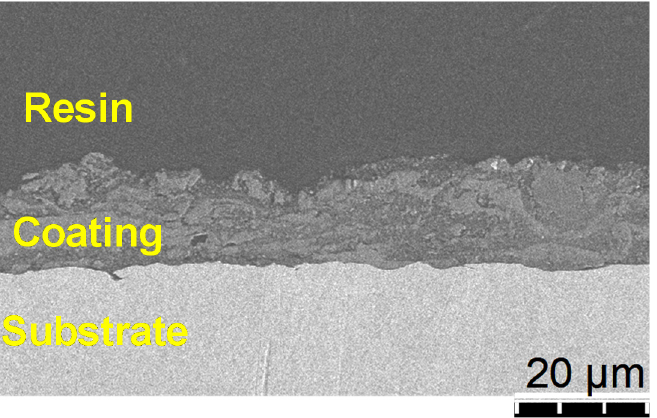
Figure 6. Cross sectional view of the AlN-rich coating on carbon steel by SEM imaging in ×2500 magnification.